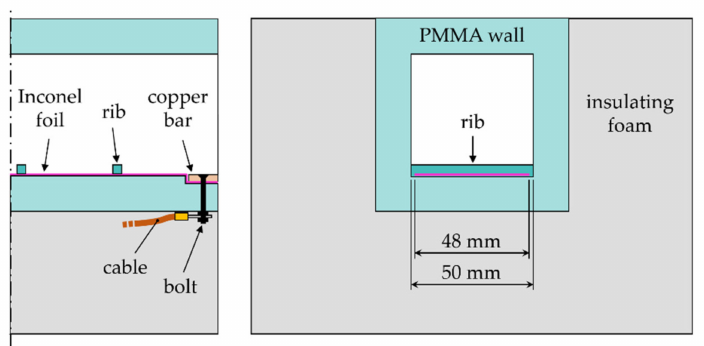
Sketch of the test article used in the steady-state liquid crystal thermography (LCT)